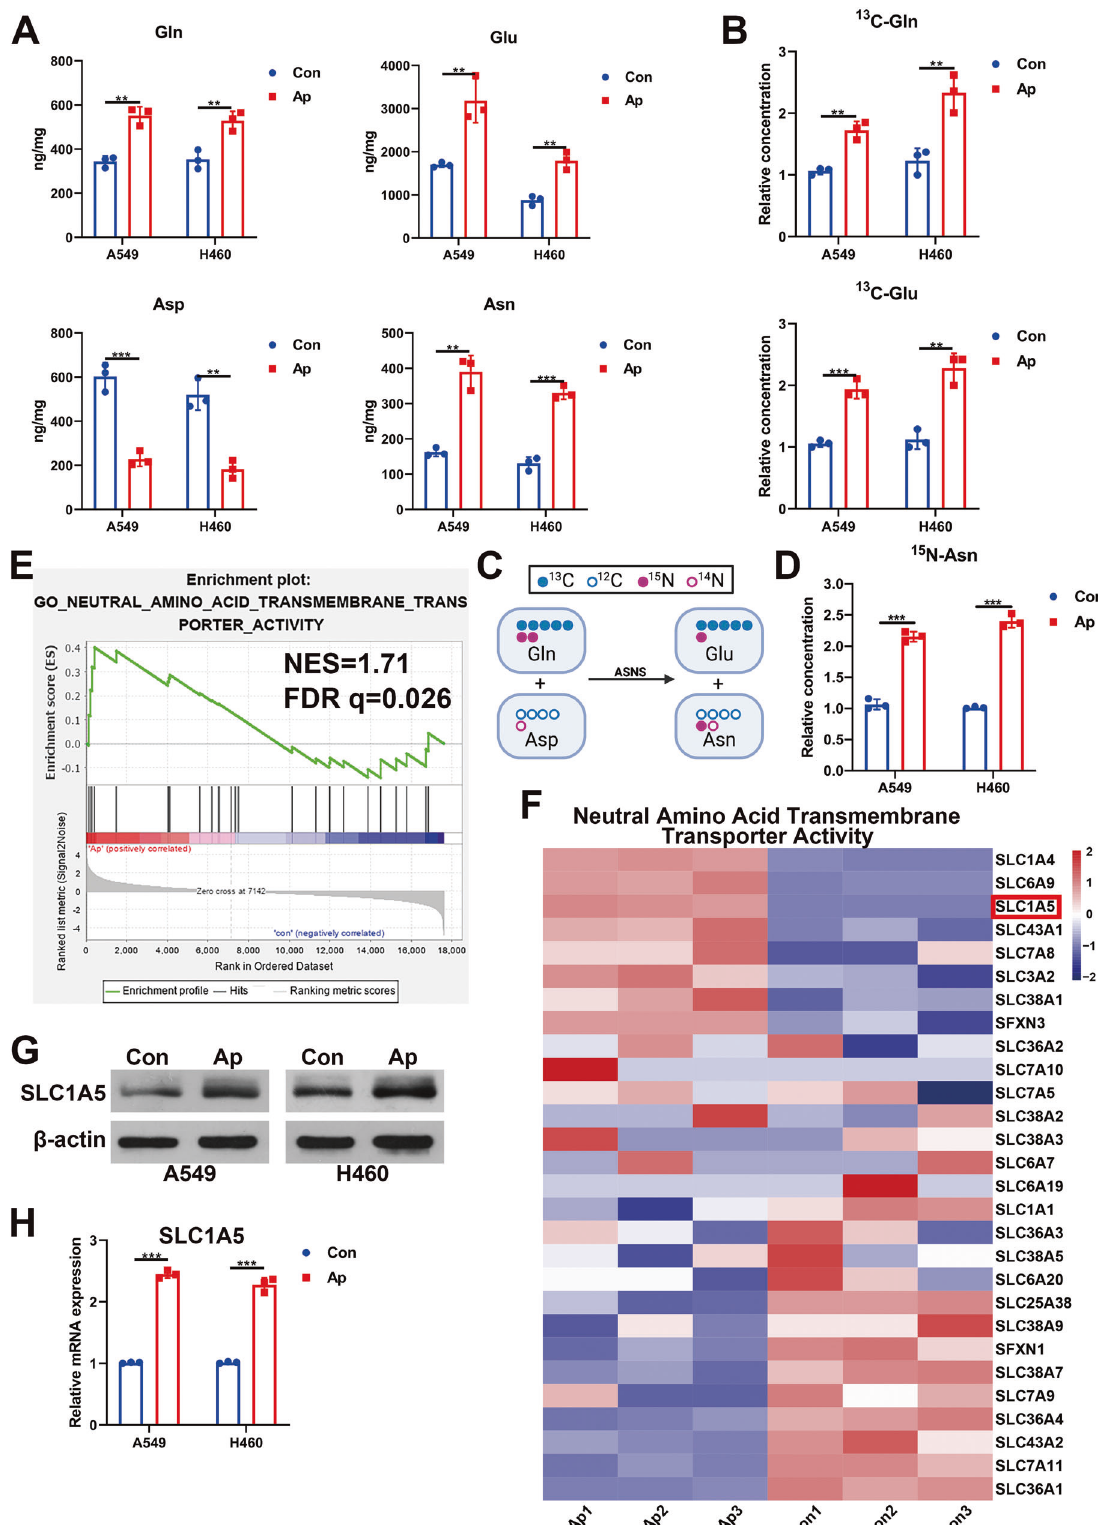
(Pearson ’ s r = 1). Furthermore, we investigated whether apatinib increased the expression of SLC1A5 and ASNS by activating ATF4. As shown in Fig. 5E, apatinib did not upregulate the expression of SLC1A5 or ASNS when ATF4 was silenced by